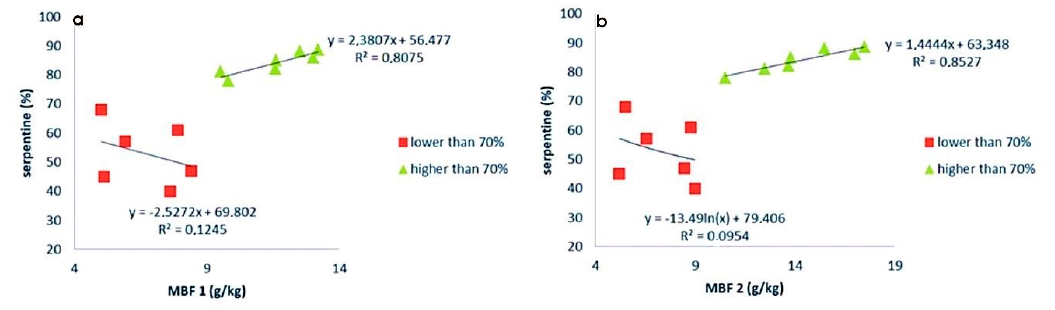
Figure 10. ( a ) Methylene blue test (MB F 1) plotted against the chlorite content of the ultramafic studied rocks, ( b ) modified methylene blue test (MB F 2) plotted against the chlorite content of the ultramafic studied rocks.